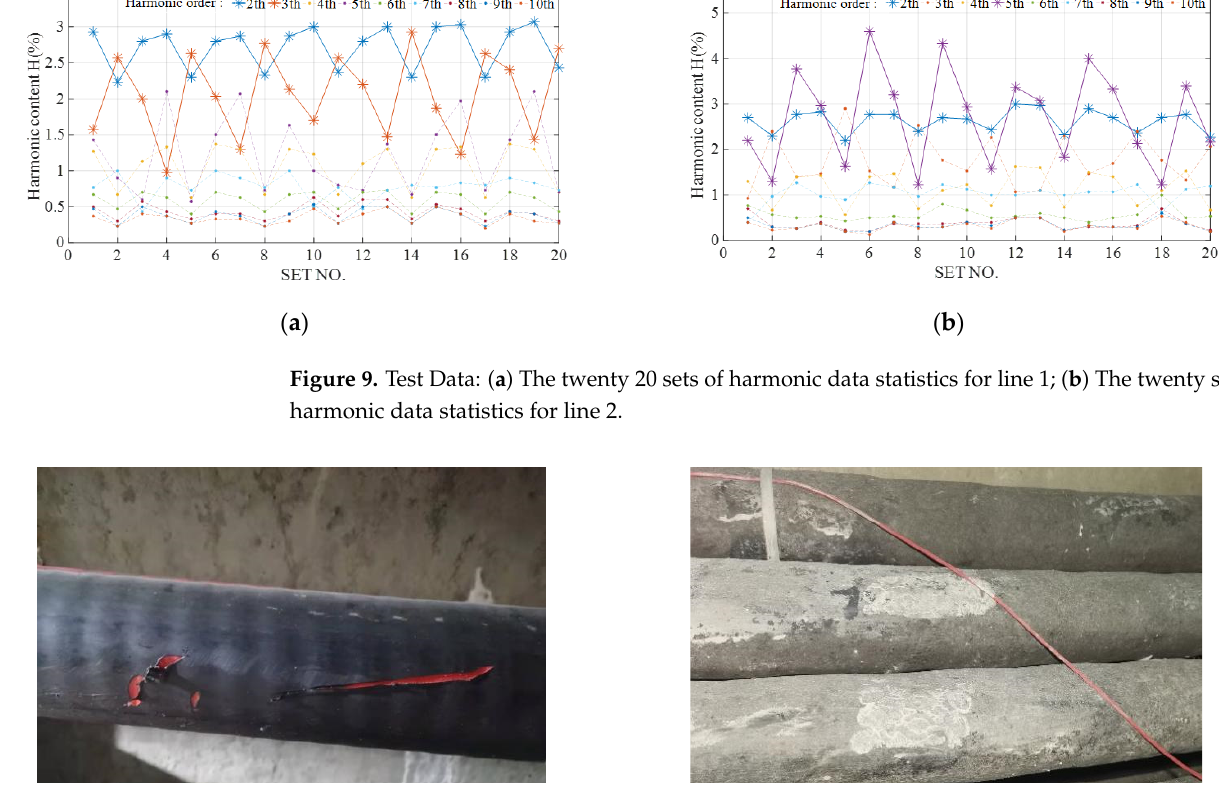
Figure 10. survey photos: ( a ) The mechanical damage type.; ( b ) The natural aging type.